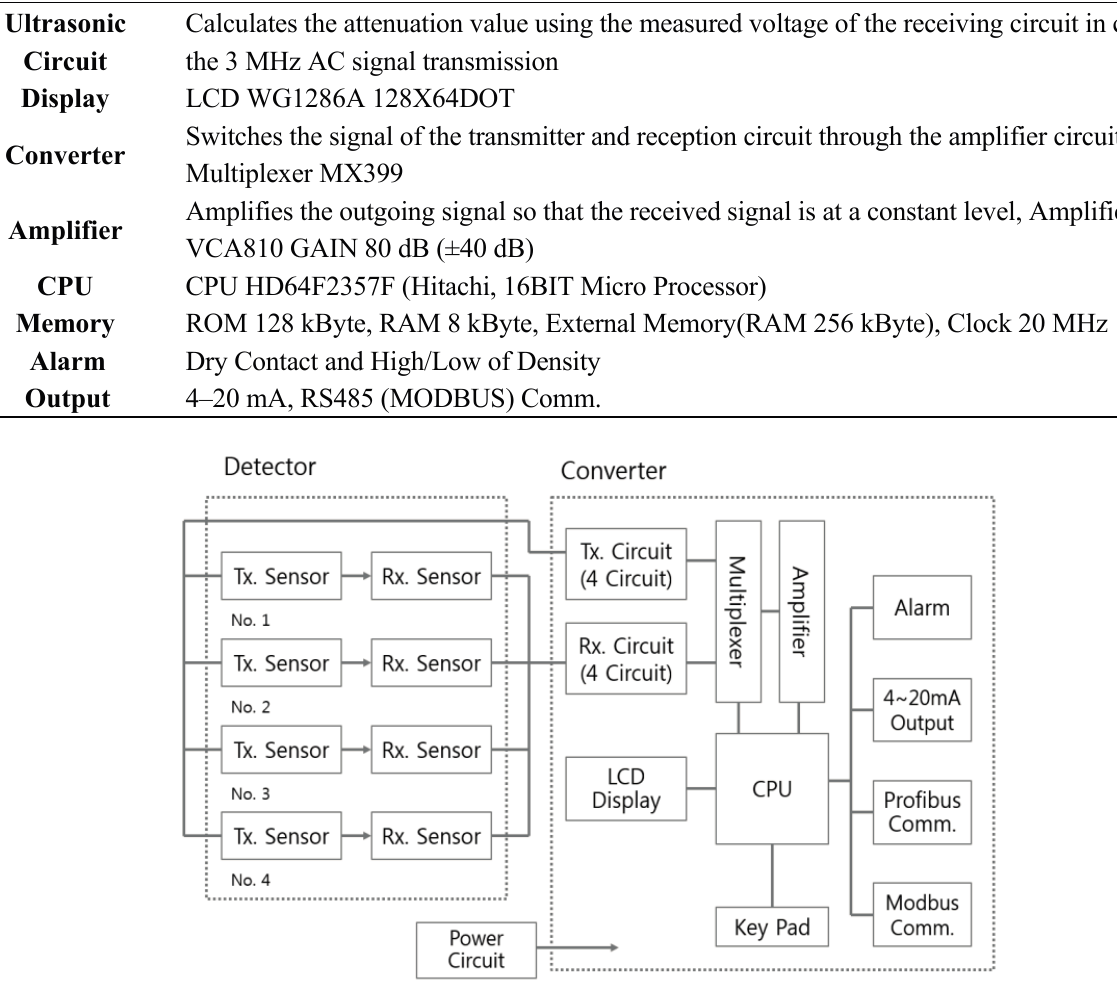
Figure 3. Block diagram of the convertor circuit.